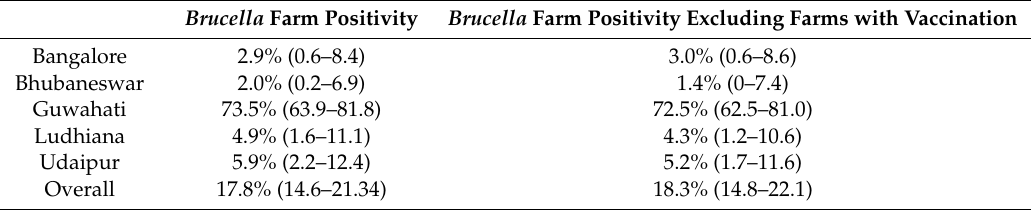
Table 2. Farm level Brucella seroprevalence (95% confidence interval) in the five di ff erent